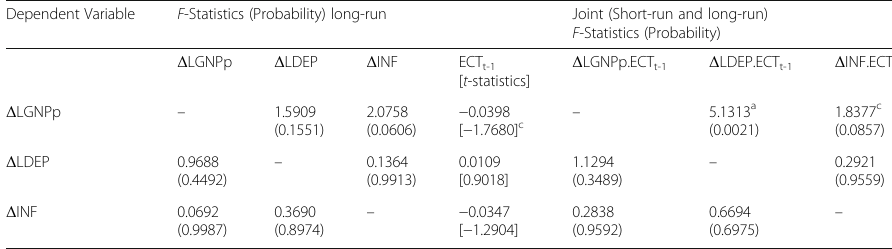
Table 9 Results of Granger Causality Tests Dependent Variable F -Statistics (Probability)